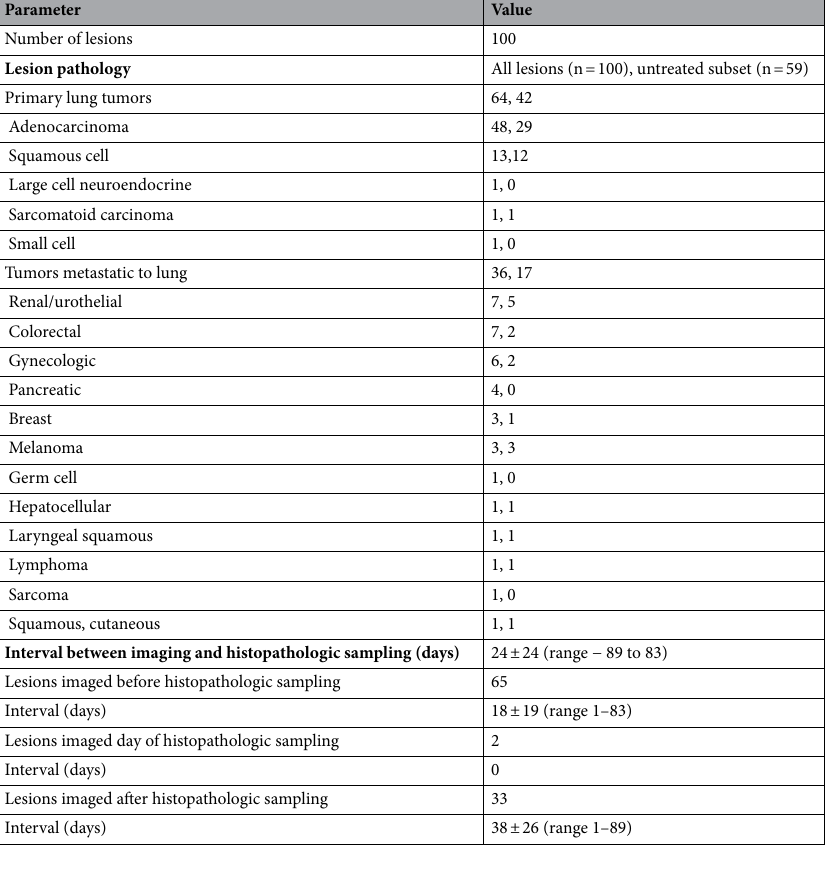
Table 1. Lesion characteristics.